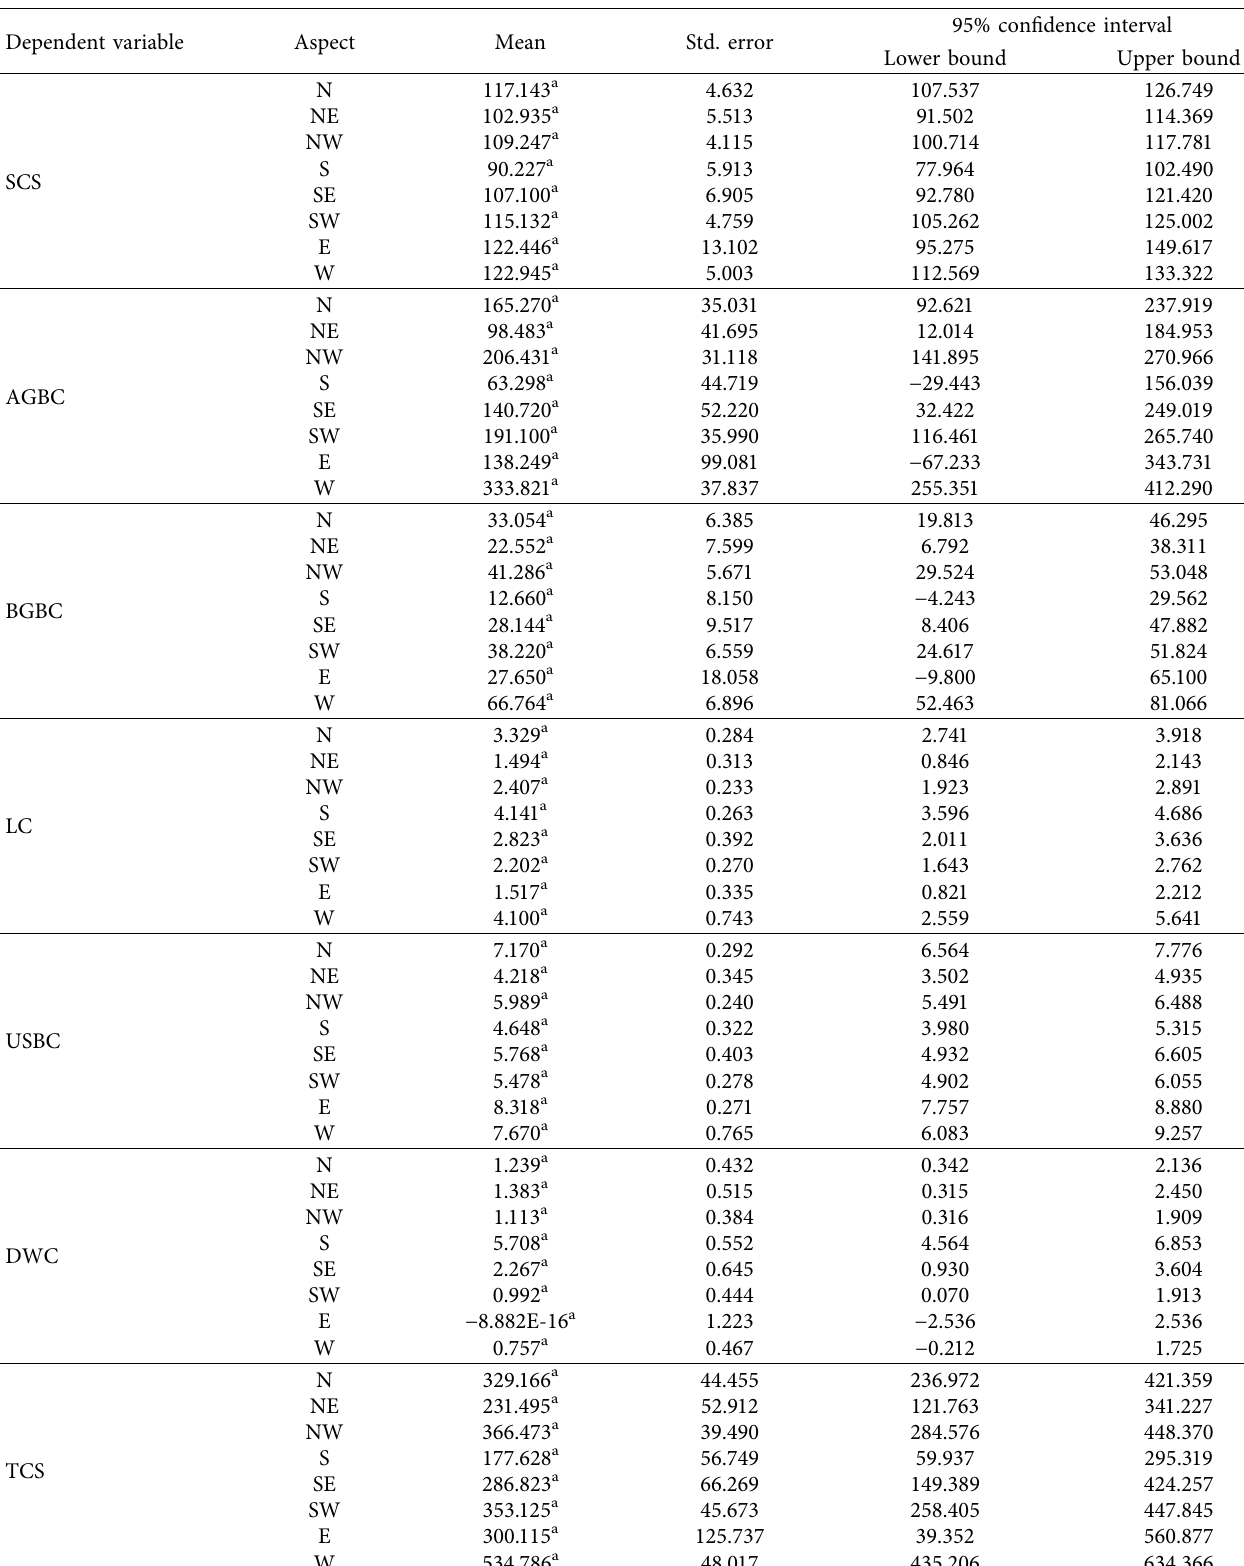
Table 13: Estimated marginal means of aspect in Anshirava